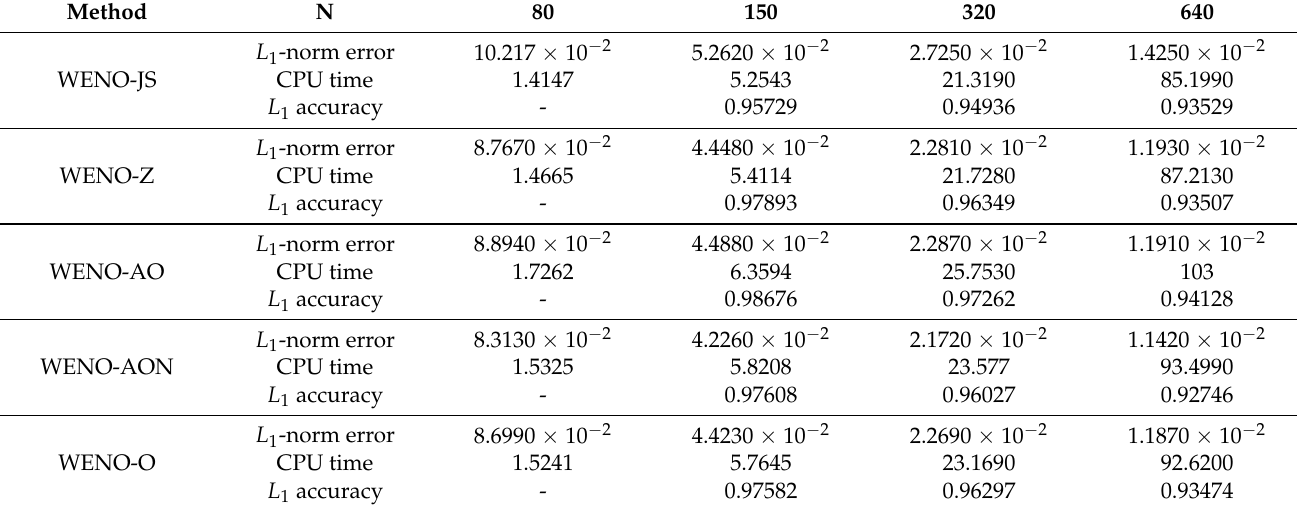
Table 7. The accuracy of Sod’s test of Example 5 (Section 6.2.2) in one dimension with WENO-AO, WENO-AON, WENO-JS, WENO-Z and WENO-O